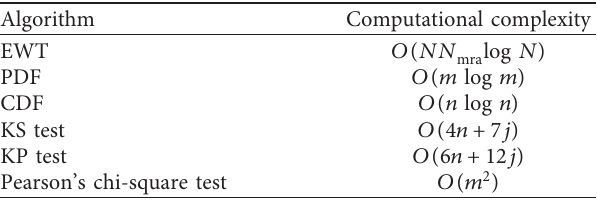
Table 4: Computational complexity.